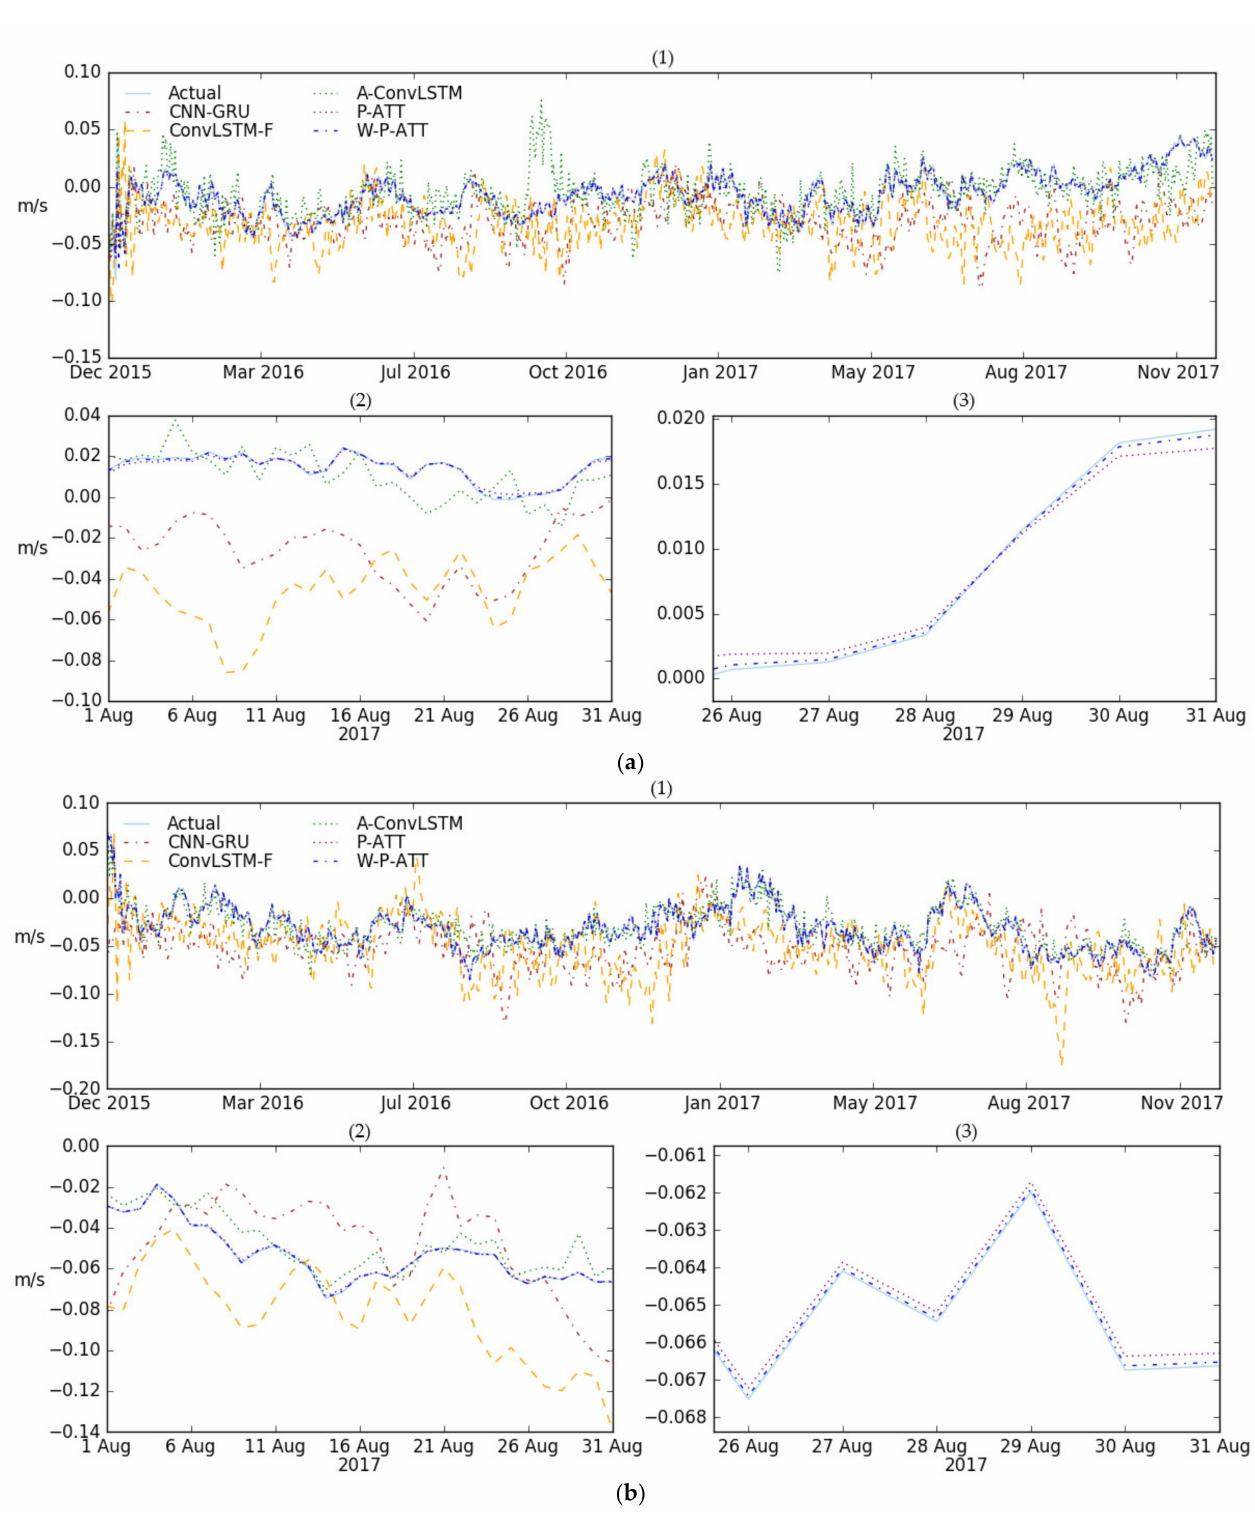
Figure 8. The comparison between the predicted OCs and observed OCs for spatial point (129.875 ◦ E, 29.5 ◦ N)—( a ) u_current, ( b ) v